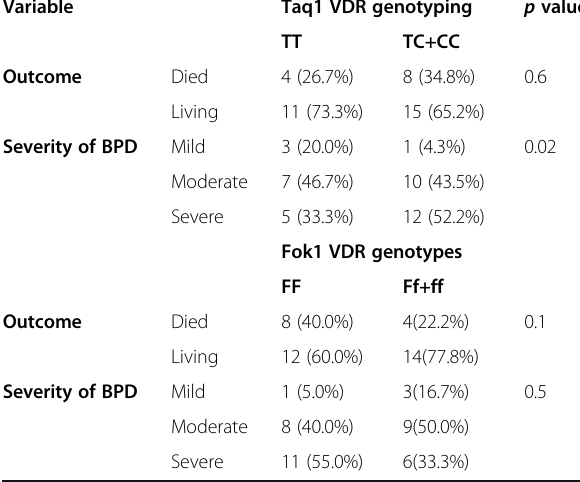
Table 5 The association between Taq 1 and Fok 1 VDR polymorphism genotypes and both the outcome and